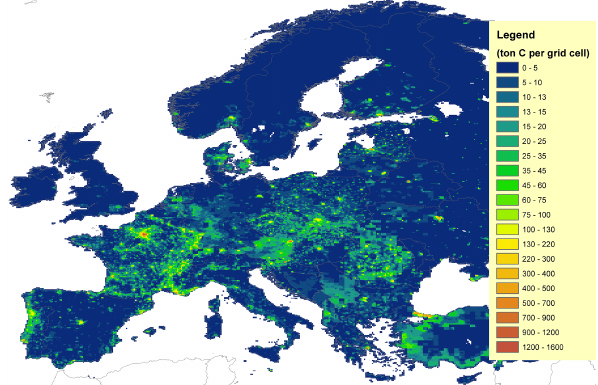
Figure 4. Spatial distribution of the OC emissions (tonnes C/grid cell; each cell is 1/8 ◦ × 1/16 ◦ long–lat, ca 7 × 7km) due to residential wood combustion in 2005 based on the TNO-newRWC inventory.